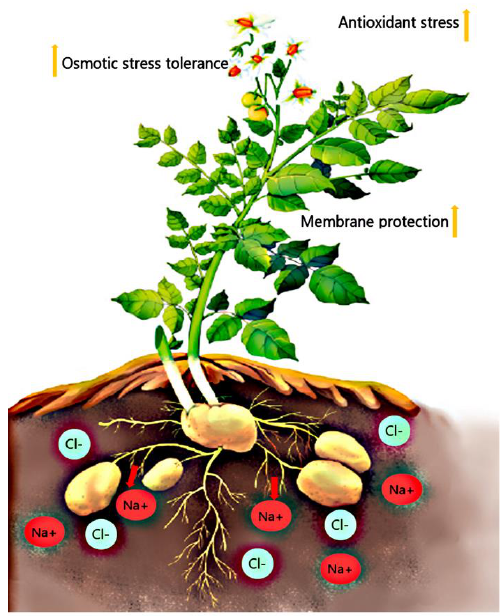
Figure 7. A hypothesis for the potato salt tolerance. The red arrow represents the Na + efflux; the yellow arrows indicate enhancement effects.